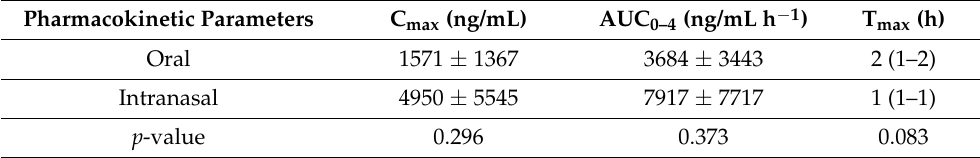
Table 2. Oral fluid pharmacokinetics parameters of oral ( n = 5) and intranasal ( n = 5) mephedrone. Pharmacokinetic